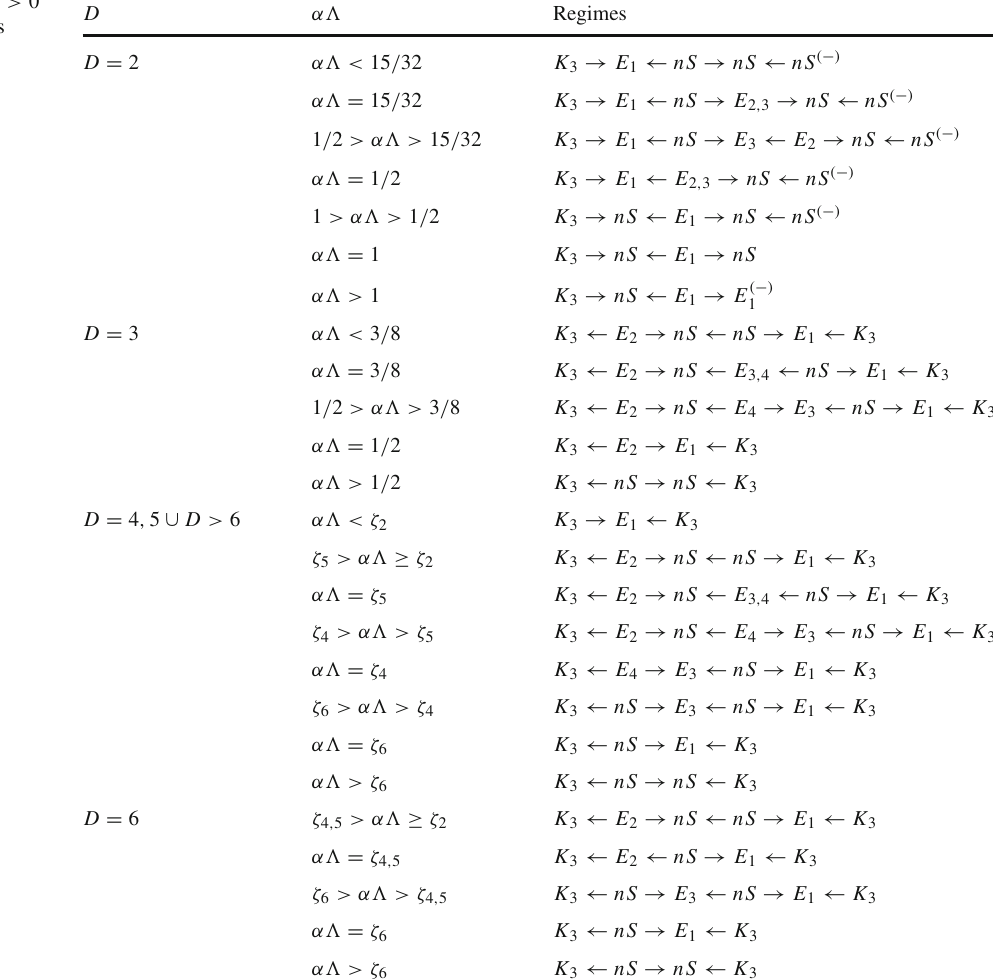
Table 4 Fine structure of α > 0 (cid:2) > 0 exponential